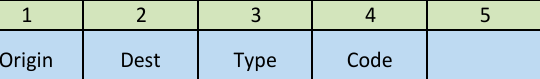
Figure 11. General flowchart of the drift algorithm in phase 2.